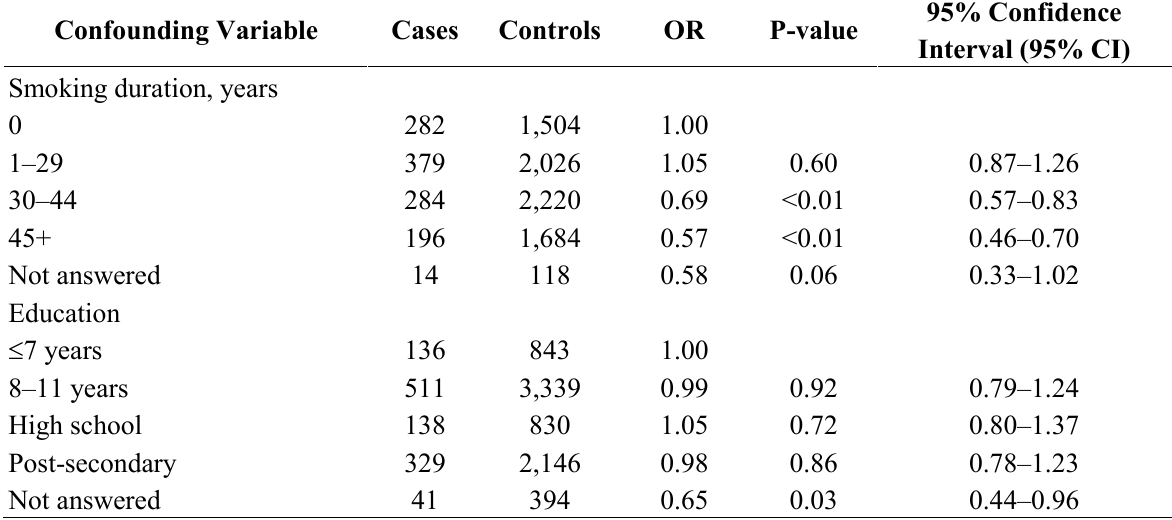
Table 3. Odds Ratios (OR) for potentially important confounding variables/effect